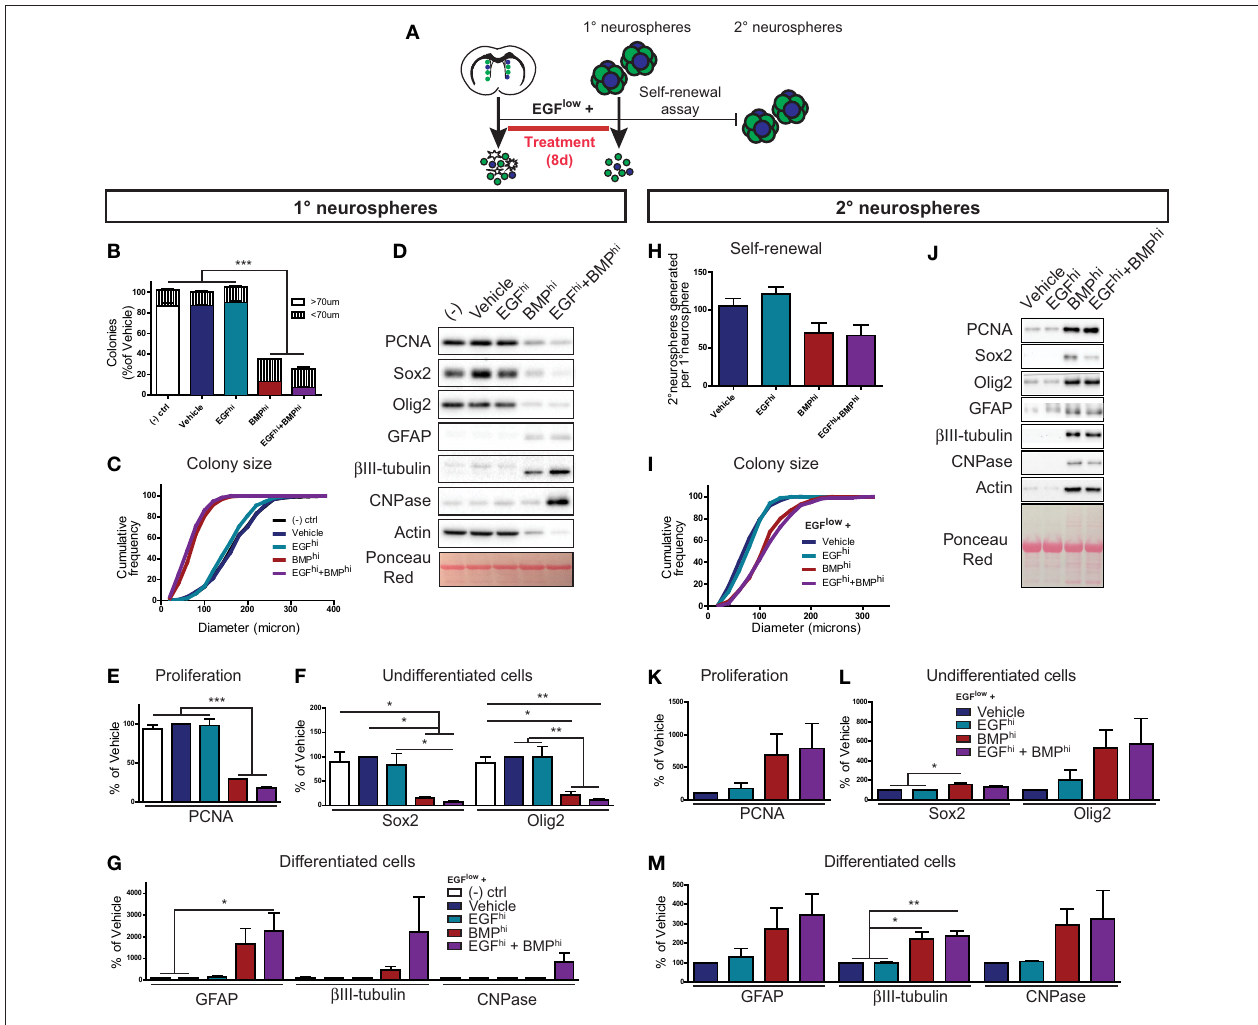
FIGURE 4 | BMP dominantly suppresses NSC activation. (A) Experimental paradigm for neurosphere assay (primary neurospheres) and self-renewal assay (secondary neurospheres) (see Materials and Methods for details) (A) . (B–G) Primary neurosphere assay. Quantification of the number of floating colonies that are greater or less than 70 microns (B) . Cumulative frequency histogram of colony sizes (C) . Western blots of lysates from treated primary neurospheres (representative example from 1 of 3 experiments) (D) . Densitometric quantifications of markers of proliferation (PCNA) (E) , TAPs (Sox2, Olig2) (F) , and neural subtypes (astrocytes, GFAP; neurons, ßIII-tubulin; oligodendrocytes, CNPase) (G) . (H–M) Self-renewal assay (see Materials and Methods for details). Quantification of the average number of secondary neurospheres generated in normal proliferation medium from each primary neurosphere (H) . Cumulative frequency graph of colony sizes (I) . Western blots of lysates from secondary neurospheres (representative example from 1 of 3 experiments) (J) . Densitometric quantifications for markers of proliferation (PCNA) (K) , TAPs (Sox2, Olig2) (L) and neural subtypes (astrocytes, GFAP; neurons, ßIII-tubulin; oligodendrocytes, CNPase) (M) . Note that BMP-treated neurospheres remain capable of generating new neurospheres, and that neurospheres generated from NSCs that had been grown in the presence of BMP are larger with altered biochemical characteristics. * p < 0.05 , * p < 0.05 , *** p < 0.001 , One-Way ANOVA (Tukey post-hoc test). Data are represented as mean ±